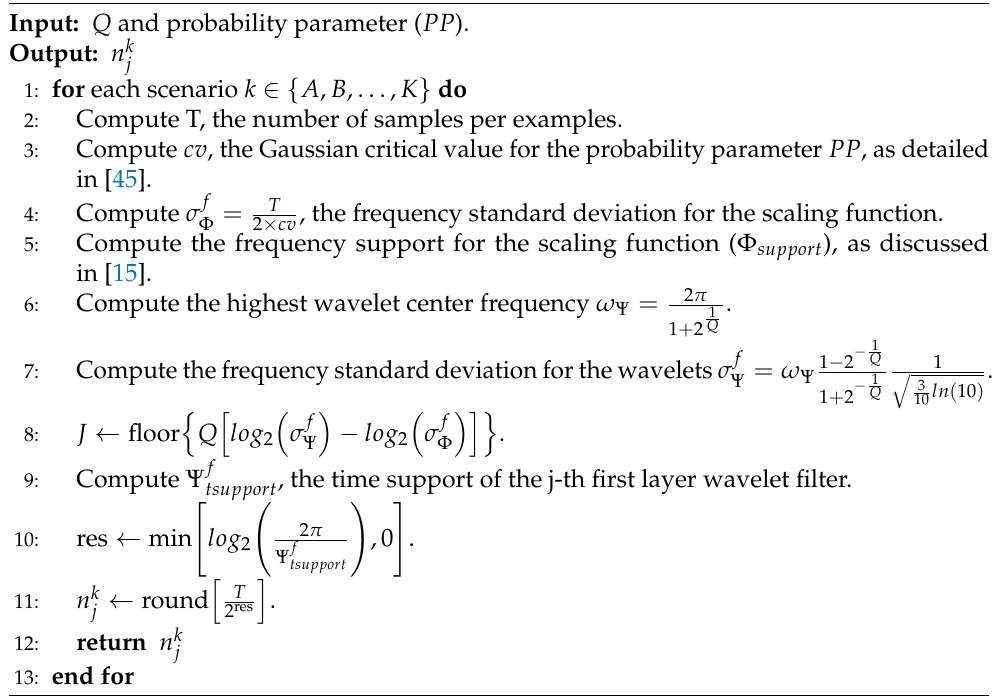
Algorithm 1 Number of scattering